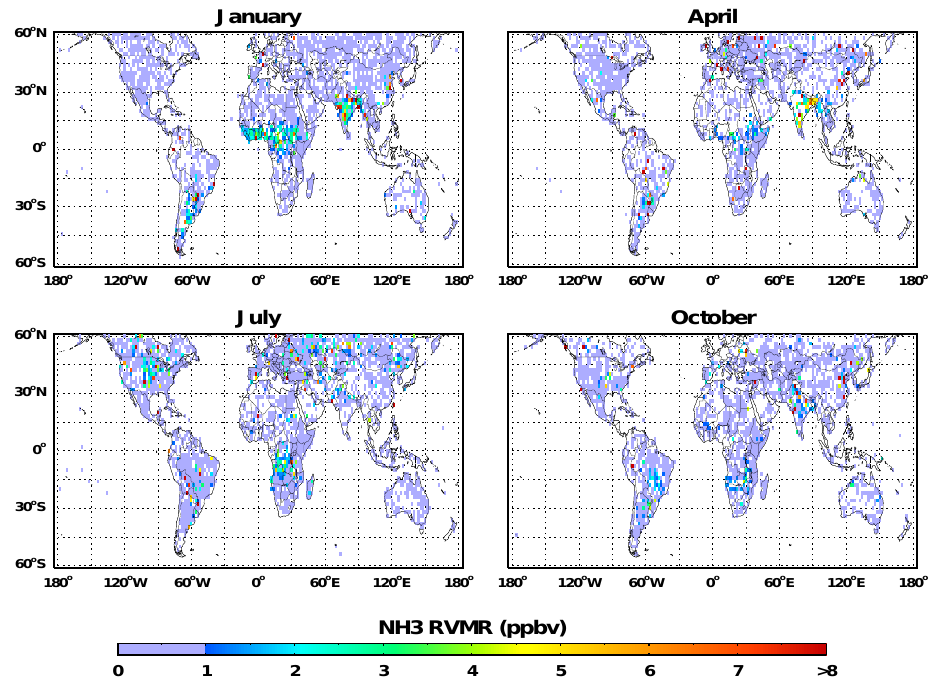
Fig. 12. GEOS-Chem with TES observational operator and RVMR applied for 2 × 2.5 ◦ averages.